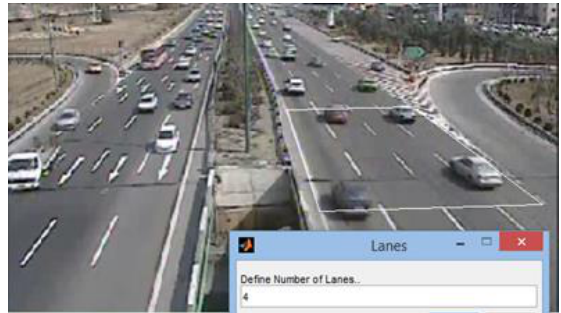
Figure 8: Definition of rea of interest and number of lanes.